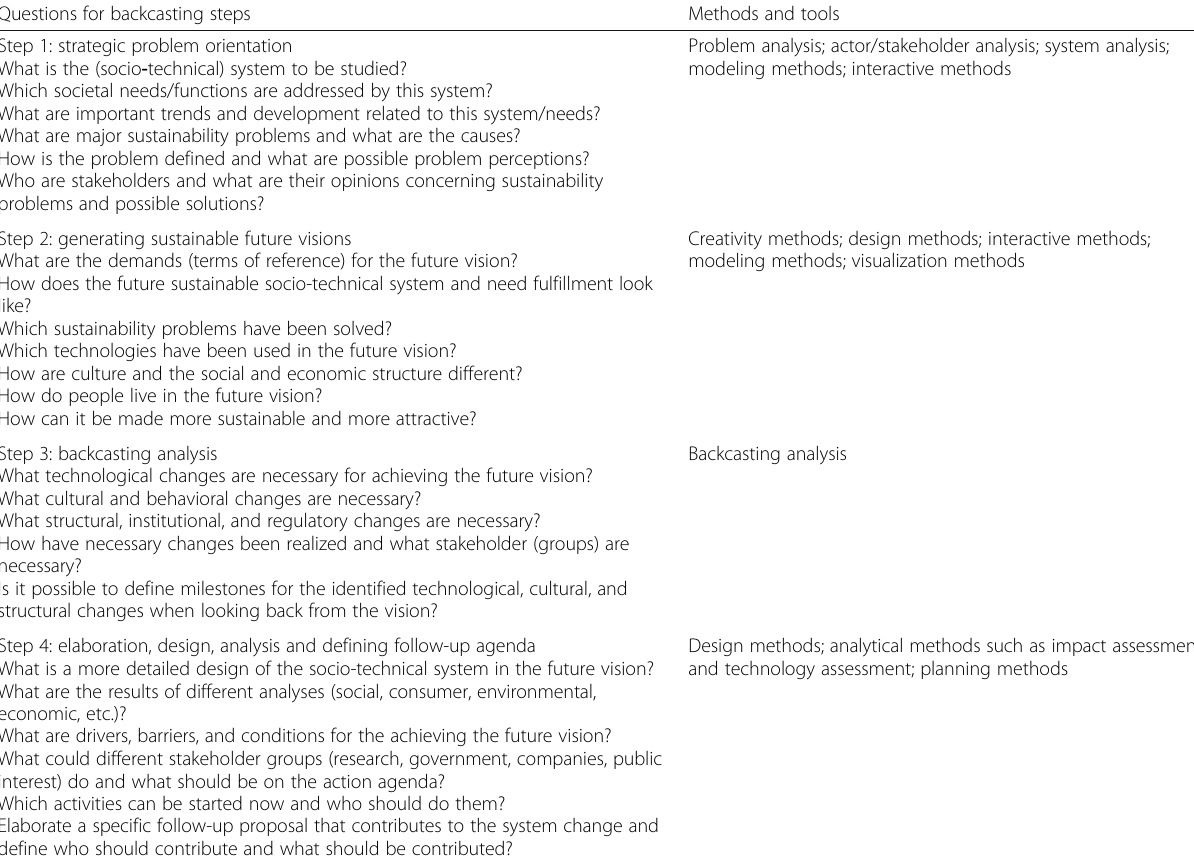
Table 3 Guiding questions for each step in the backcasting study Questions for backcasting steps Methods and